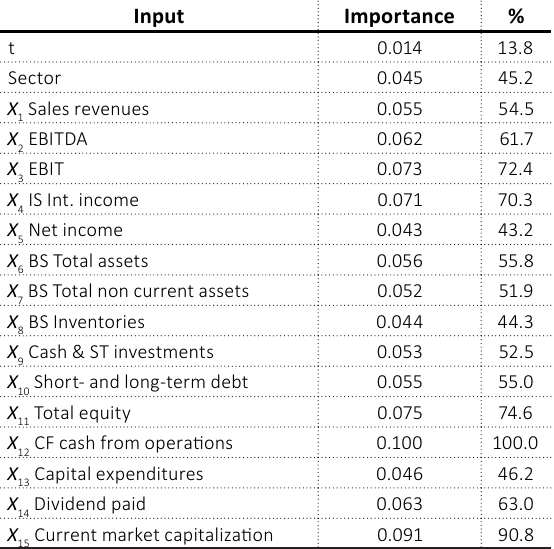
Table 16. Importance and normalized importance of each explanatory variable Input